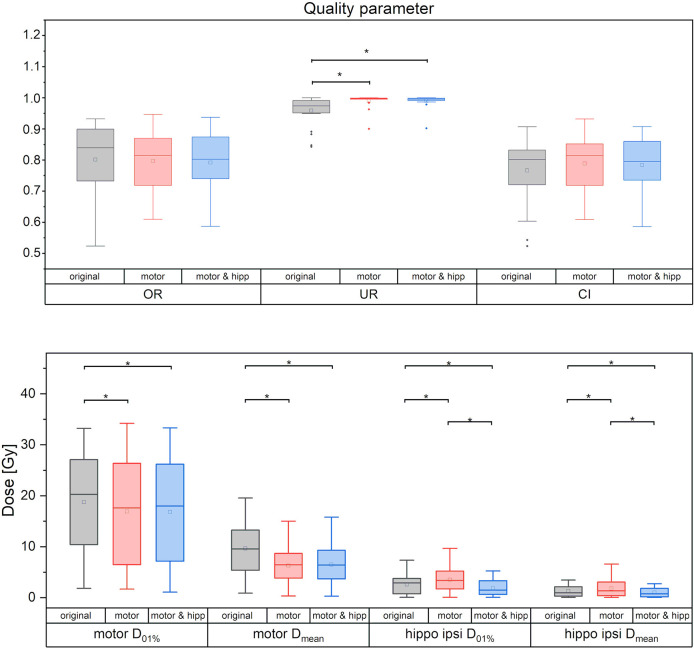
Quality measures of planning target volume (PTV) coverage (upper panel) and dose to motor cortex and ipsilateral hippocampus. Statistically significant differences are denoted by asterisk.